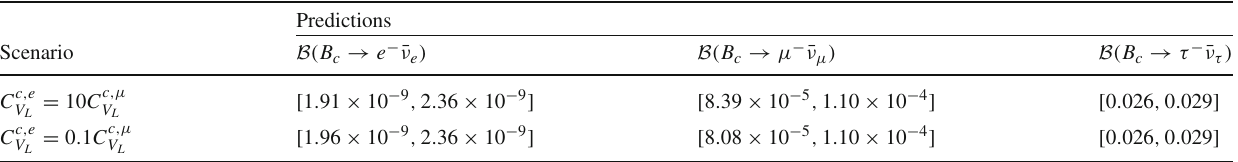
,μ and C c . V L V L